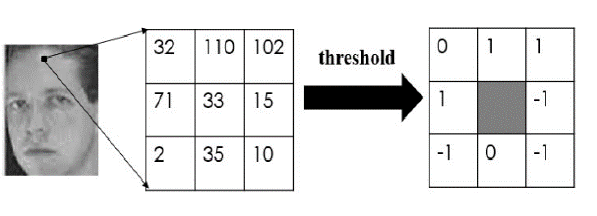
Figure 2. Illustration of the basic Local ternary patterns operator with